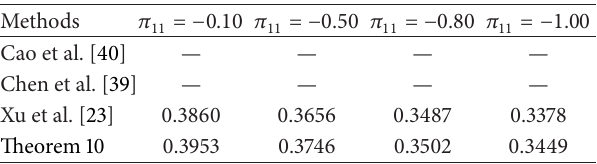
Table 4: Maximum upper bound of 𝑑 2 with 𝜇 = 1.5 and different parameter 𝜋 11